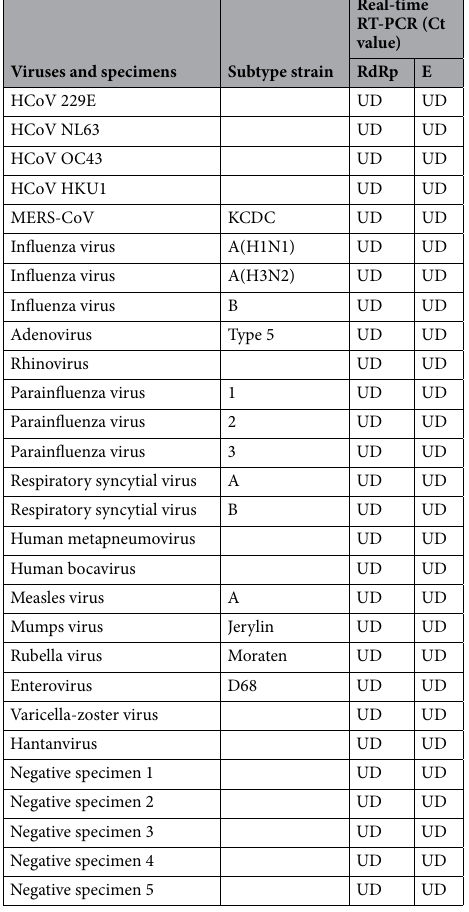
Table 3. Specificity evaluation of the SARS-CoV-2 RT-qPCR assay using known respiratory viruses and respiratory specimens and primers to the SARS-CoV-2 RdRp and E genes. UD, Undetected; negative specimen, specimens known to be negative for SARS-CoV-2.